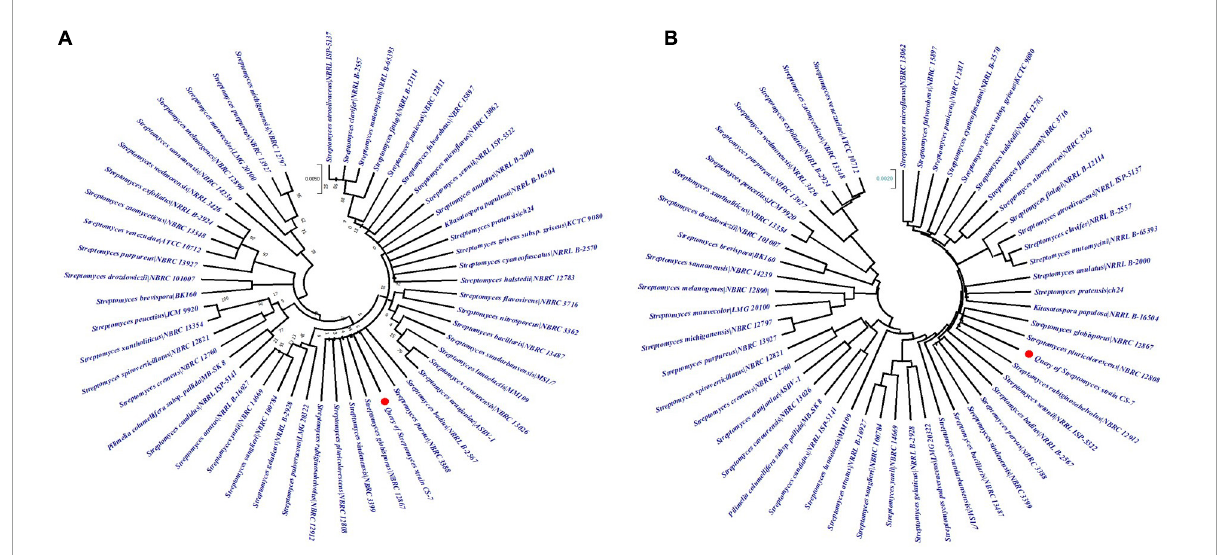
FIGURE4 Analysis of phylogenetic links among the close taxa. The phylogenetic lineage was inferred using (A) the Maximum Likelihood method and (B) the Neighbor-Joining method. The numbers above branches are GBDP pseudo-bootstrap support values from 100 replicates and only values above 50% are shown.